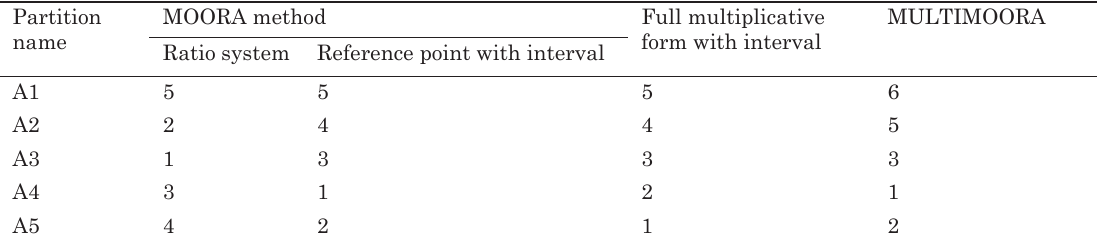
Table 7. Ranking the most efficient alternatives